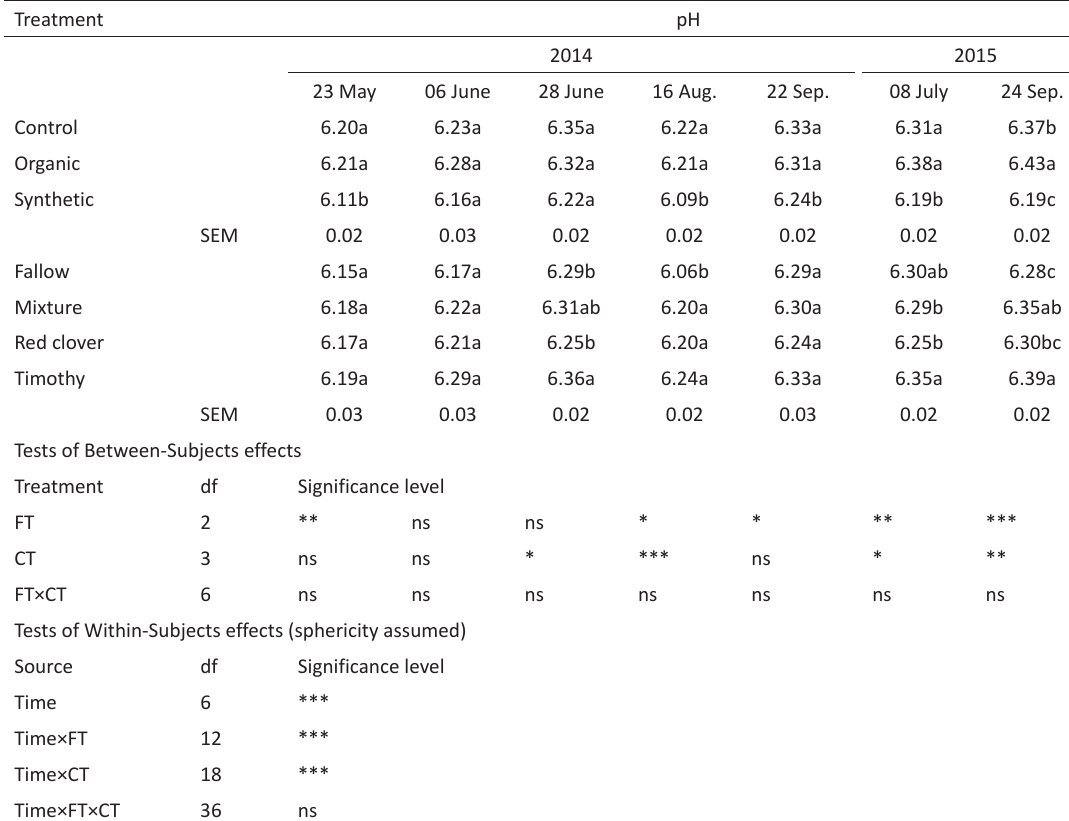
Table 5. Soil pH under different fertilizer and crop treatments Treatment